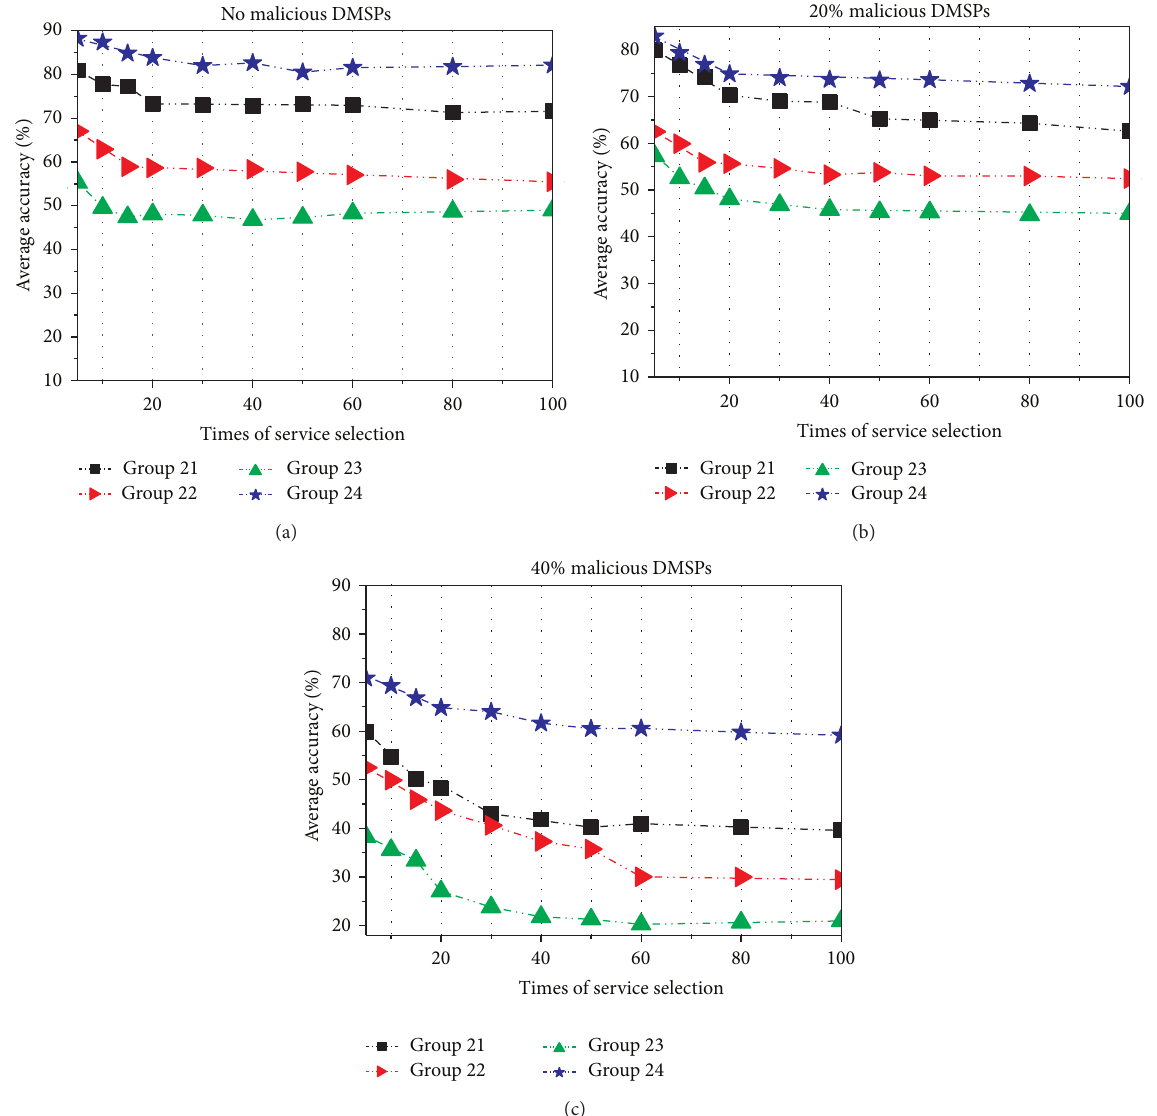
Figure 8: Effects of the capacity